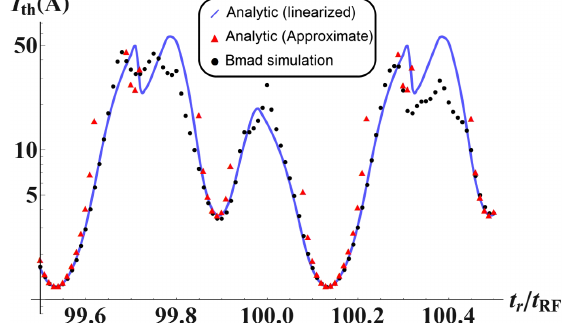
FIG. 15. Comparison of the I obtained from the linearized th formula and BMAD simulation for N p ¼ 4 . Parameters used are the same as in Fig. 14, with T 12 ¼ T IJ and t r ¼ t I − t J for any I ¼ J þ 1 . The trough regions are where the approximate formula (red triangles) is